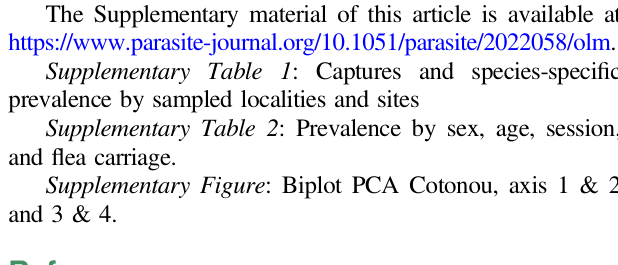
Supplementary Table 1 : Captures and species-speci fi c prevalence by sampled localities and sites Supplementary Table 2 : Prevalence by sex, age, session, and fl ea carriage. Supplementary Figure : Biplot PCA Cotonou, axis 1 & 2 and 3 &